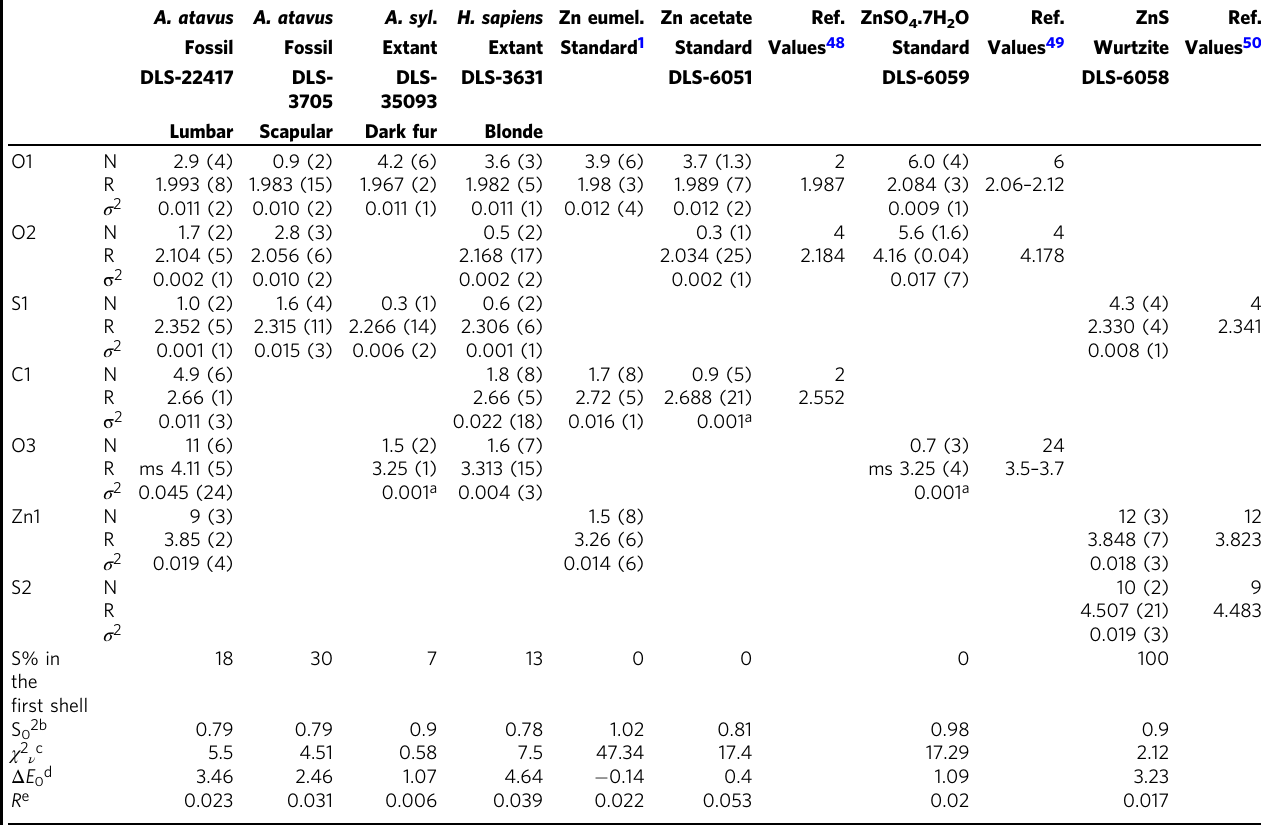
Table 1 Zn K-edge EXAFS for fossil fur and standard compounds